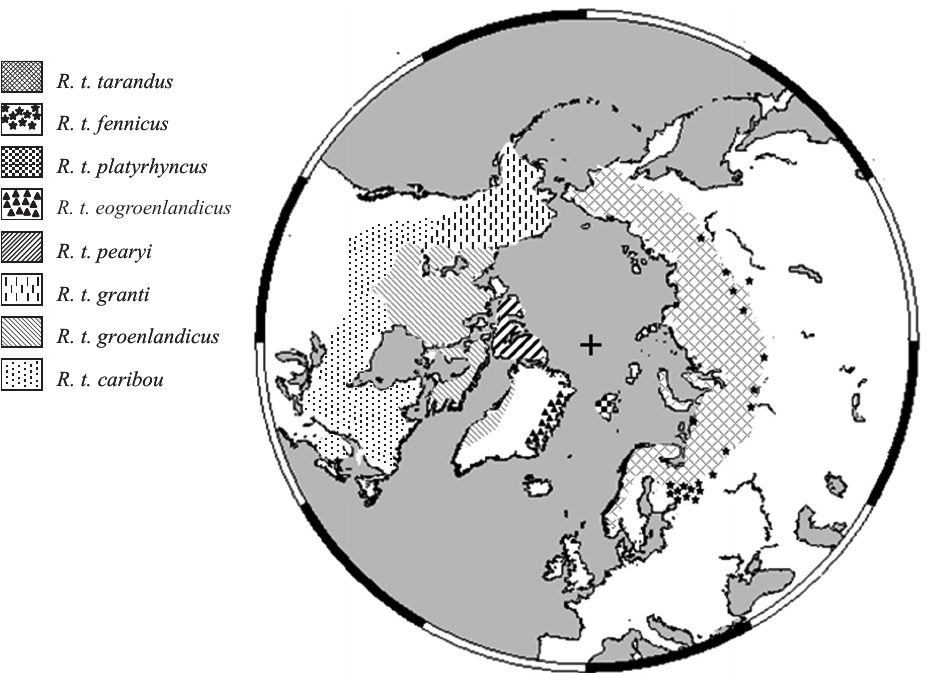
Fig. 1. Geographic distribution of the different subspecies of reindeer. Although additional subspecies have been suggested, these eight constitute the conventional taxonomic classification of the